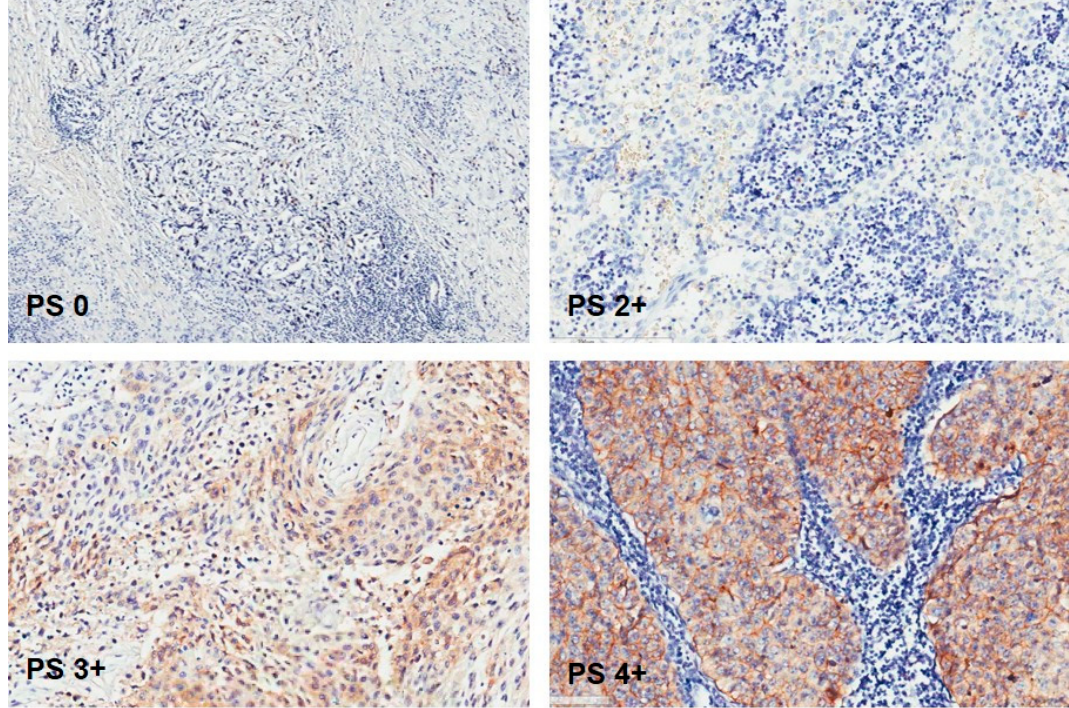
Figure 2. Lymph node metastasis without EpCAM expression. Lymph node metastases with EpCAM expression with proportion score 2 : 10 – 50%; 3 : 51 – 80%; and 4 : >80%. Original magnification: 200 × .